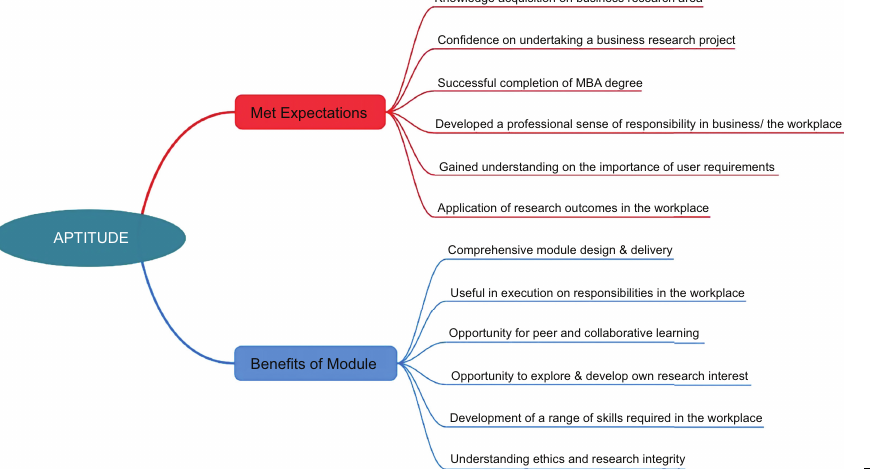
Figure 4. Interview themes: Benefits associated with business and management